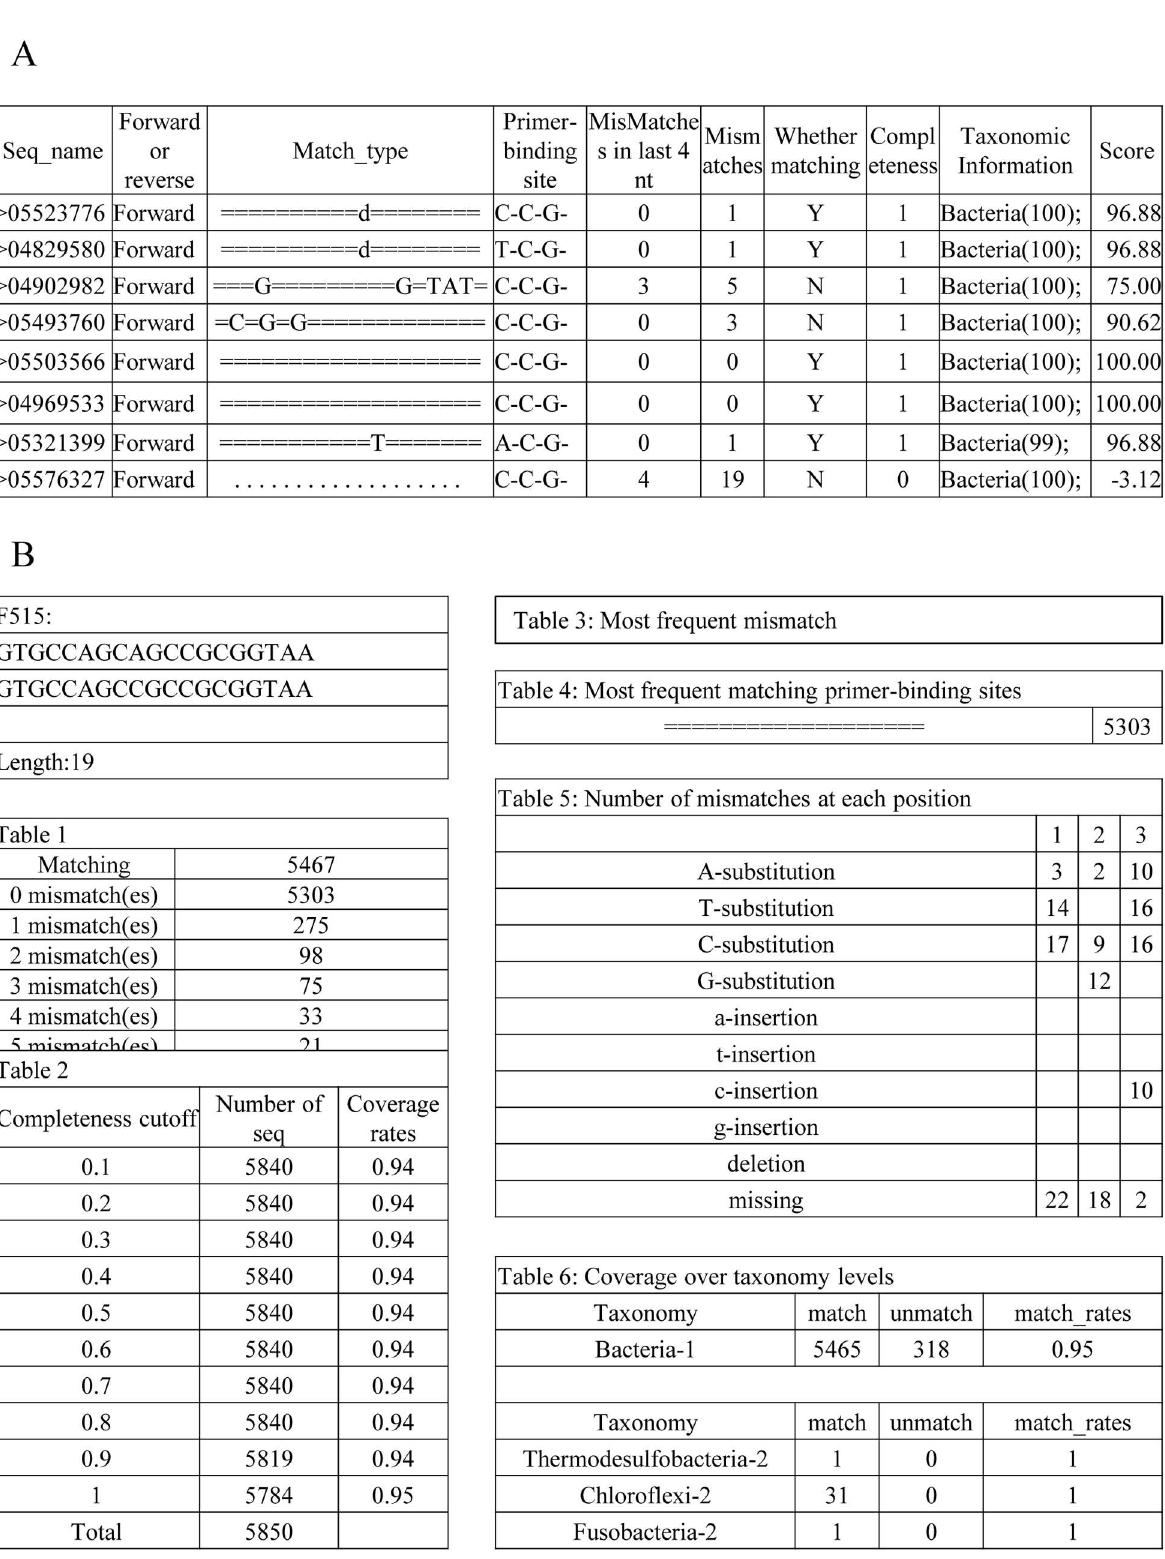
PLOS ONE | https://doi.org/10.1371/journal.pone.0174609 March 28,